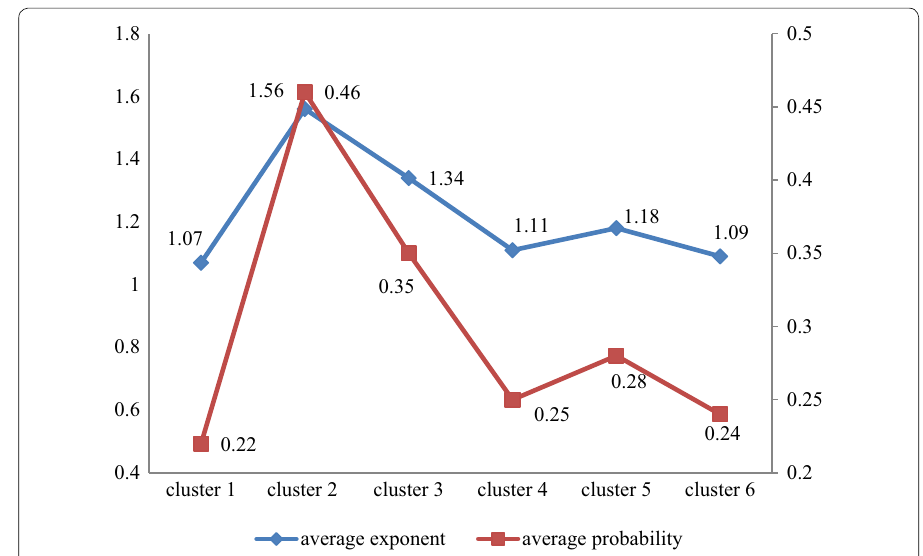
Fig. 9 The relationship between the two statistical values. This figure shows the relationship between average exponent of spatial distribution and average probability of